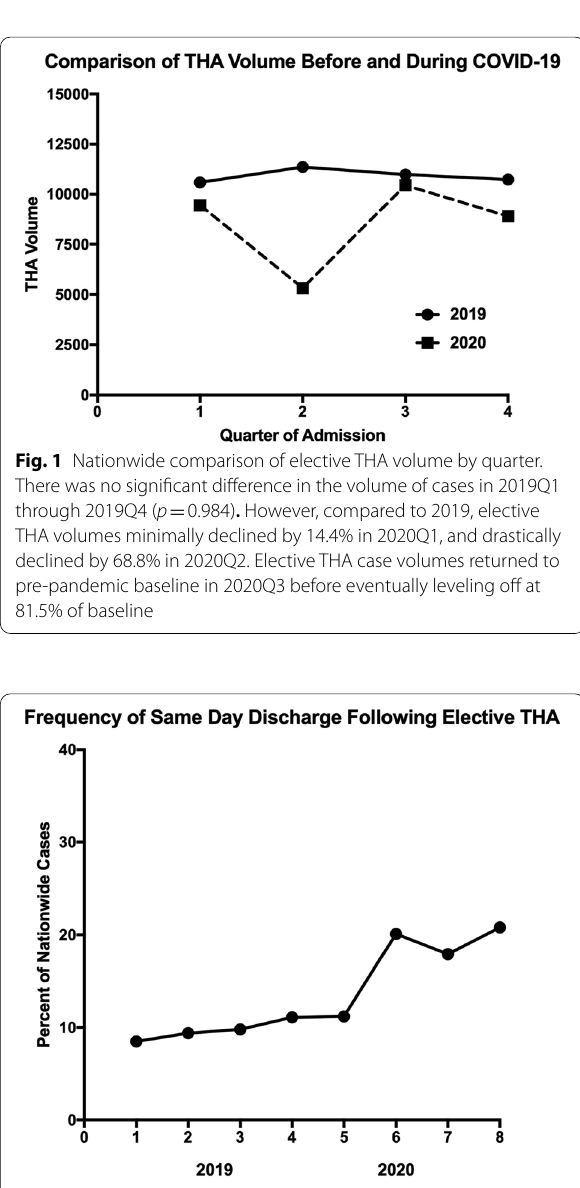
vs . 2.93%) rates following elective THA were low in our